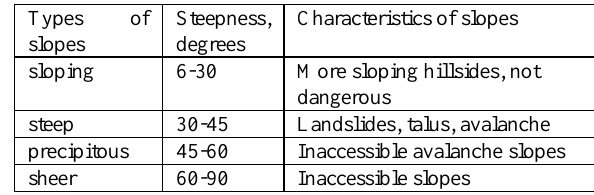
Table 1. Classification of steep slopes highlands